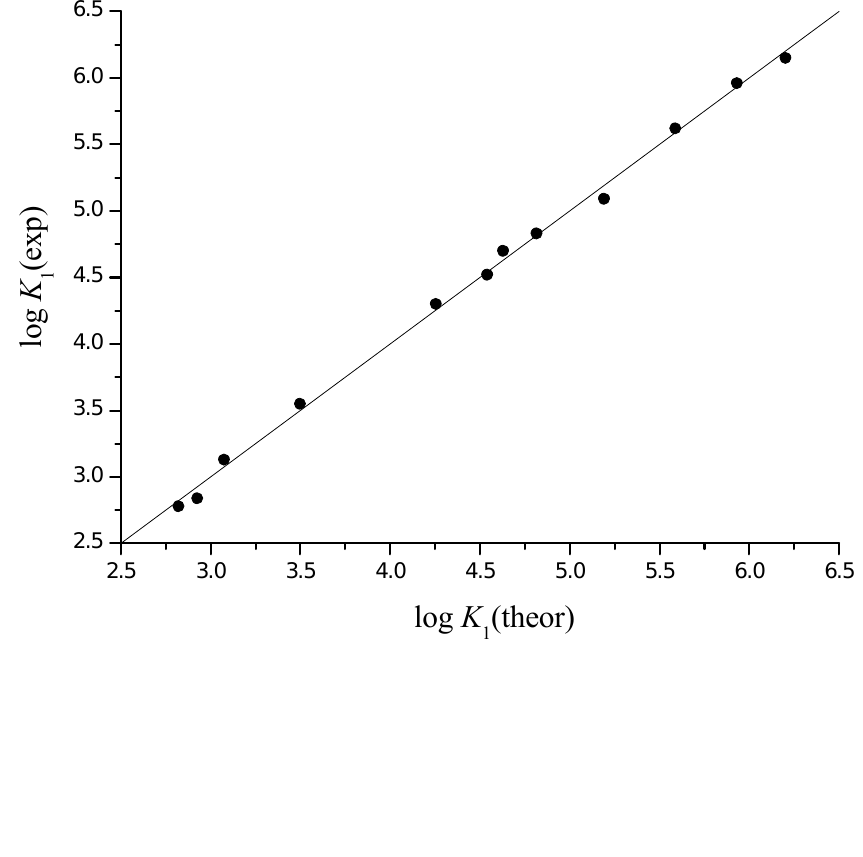
for Mn 2+ , Fe 2+ , Co 2+ , and Ni 2+ complexes 1 = cv